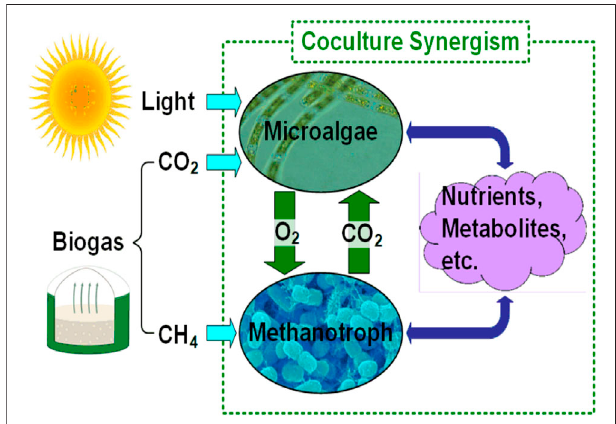
FIGURE 1 | Synergistic interactions within microalgae-methanotroph